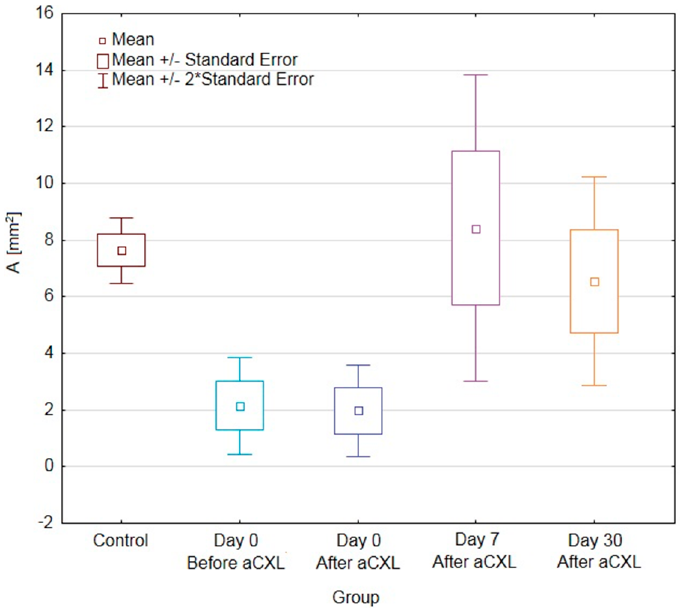
Figure 2. Box-and-whiskers plot of conjunctival ultraviolet autofluorescence (CUVAF) nasal and temporal area (AN + T) measurements in keratoconical eyes undergoing accelerated corneal cross-linking (aCXL) procedure and untreated keratoconical eyes as well as the eyes of control group patients. Abbreviations: CUVAF, conjunctival ultraviolet autofluorescence; AN + T, nasal and temporal conjunctival autofluorescence area; aCXL, accelerated corneal cross-linking.